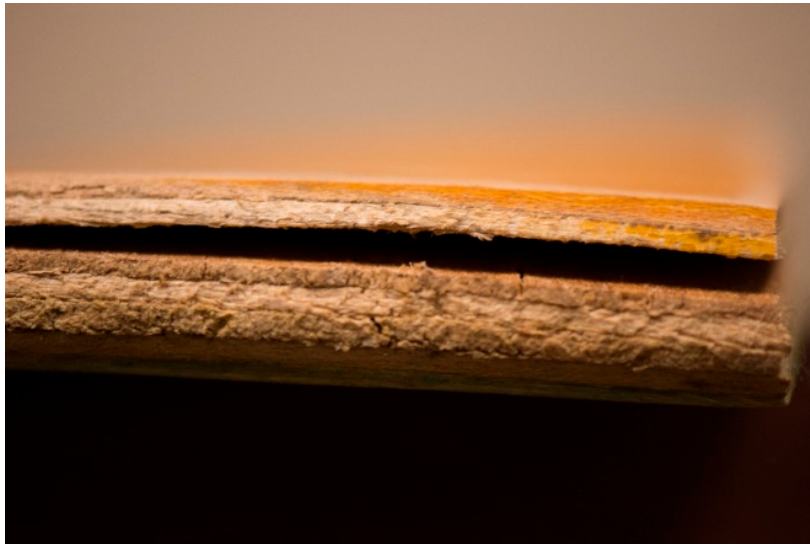
Figure 16. Face wise view of sample 4 showing delamination after soak/dry moisture durability test (ANSI/HVPA EF 2009 [4]).